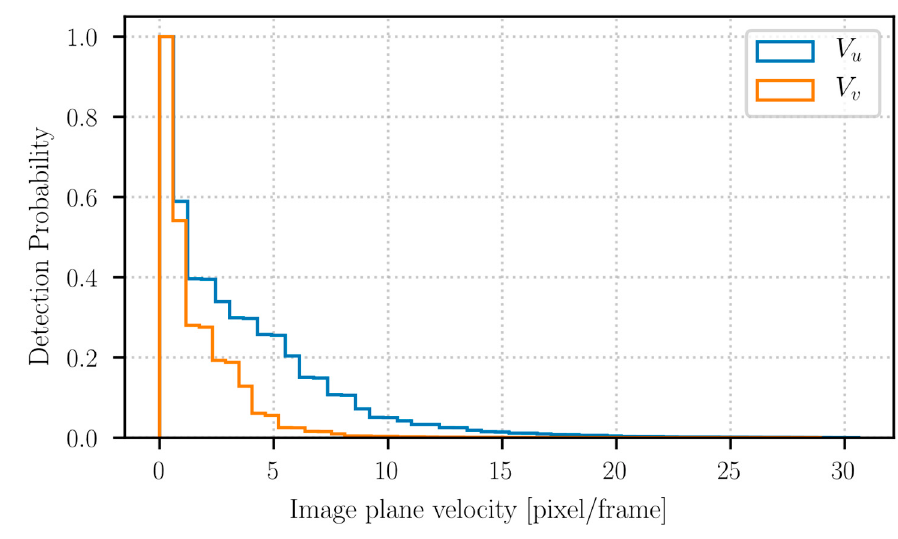
Figure 12. Horizontal and vertical speeds detection rate in the image plane.